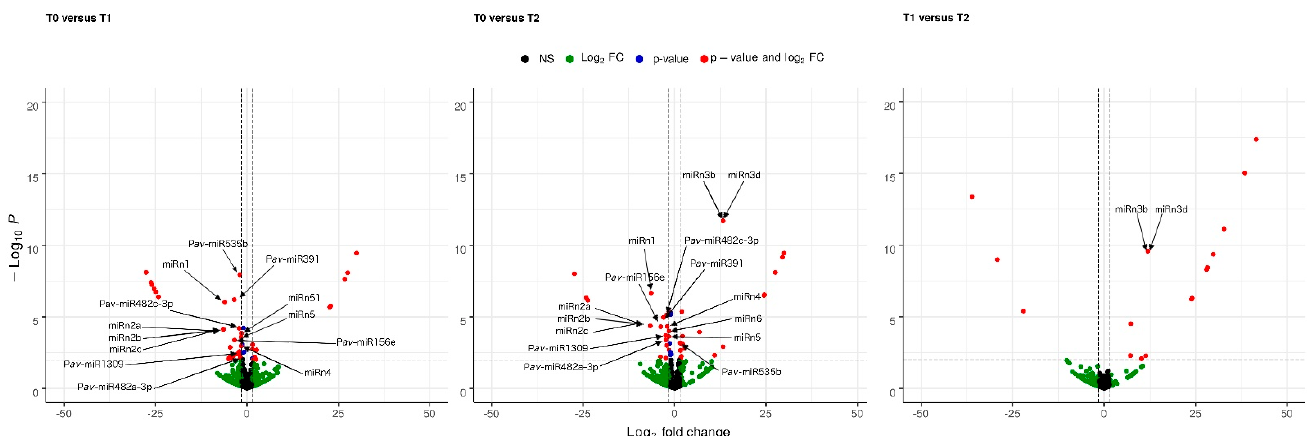
Figure 2. Identification of differentially expressed Prunus avium miRNA-like molecules. Pairwise comparisons of the differentially expressed miRNAs between three different cold chilling hours’ (CH) accumulation of field chilling (FC) conditions, denoted by T0 (paradormancy, 0 CH), T1 (en- dodormancy, 853 CH), and T2 (ecodormancy, 909 CH). Comparisons are indicated on the graphs. Red dots indicate miRNA-like molecules that show log fold change ≥ 1.5 ( x -axis), as well as high statistical significance ( p -value ≤ 0.01, y -axis). Blue dots indicate miRNA-like molecules that show log fold change ≤ 1.5 ( x -axis), despite the high statistical significance ( p -value ≤ 0.01, y -axis). Green dots indicate miRNA-like molecules that log fold change ≥ 1.5 ( x -axis) but lower statistical significance ( p -value ≥ 0.01, y -axis).